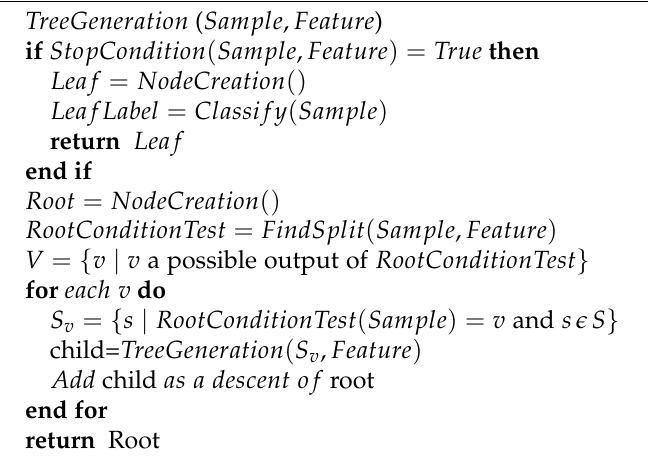
Algorithm 2 Decision